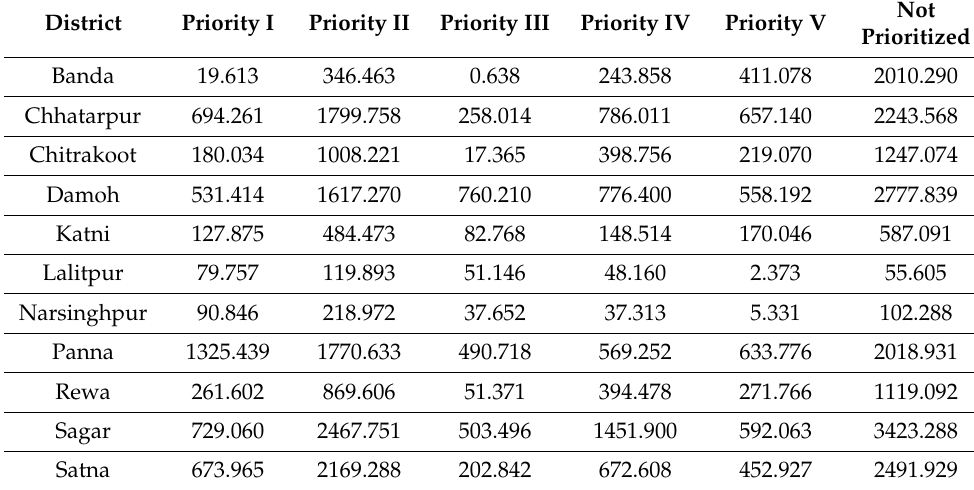
Table 6. District-wise area (in km 2 ) distribution for different priority regions of conservation. District Priority I Priority II Priority III Priority IV